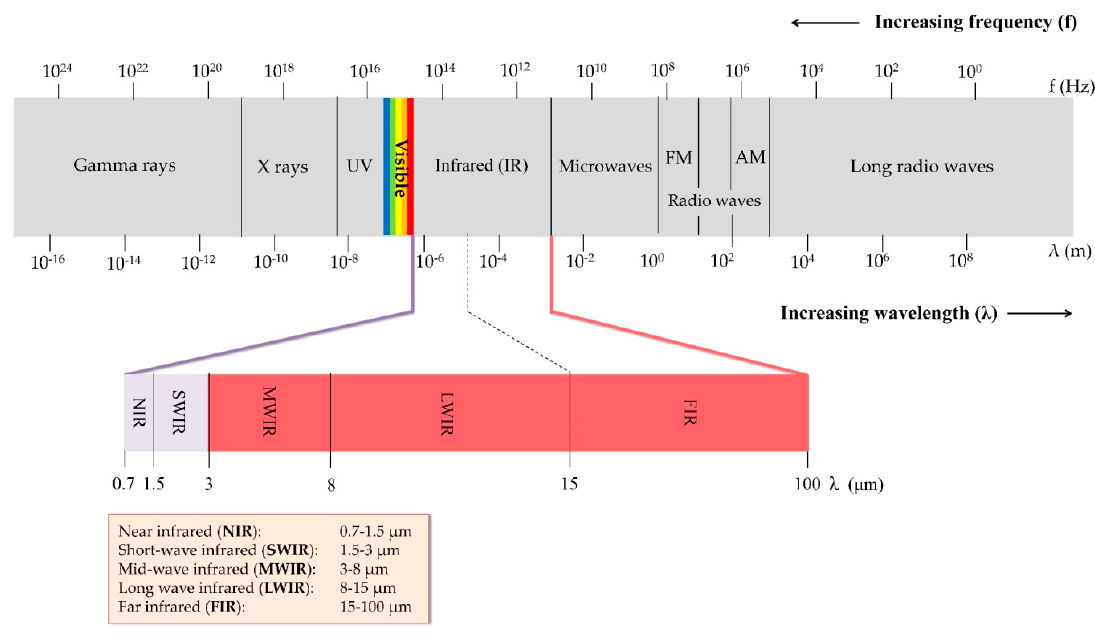
Figure 1. The electromagnetic (EM) spectrum. In evidence, the infrared (IR) region, in which the reflected-IR (0.7–3.0 µ m) and the emitted-IR (3.0–100 µ m) are further detailed.